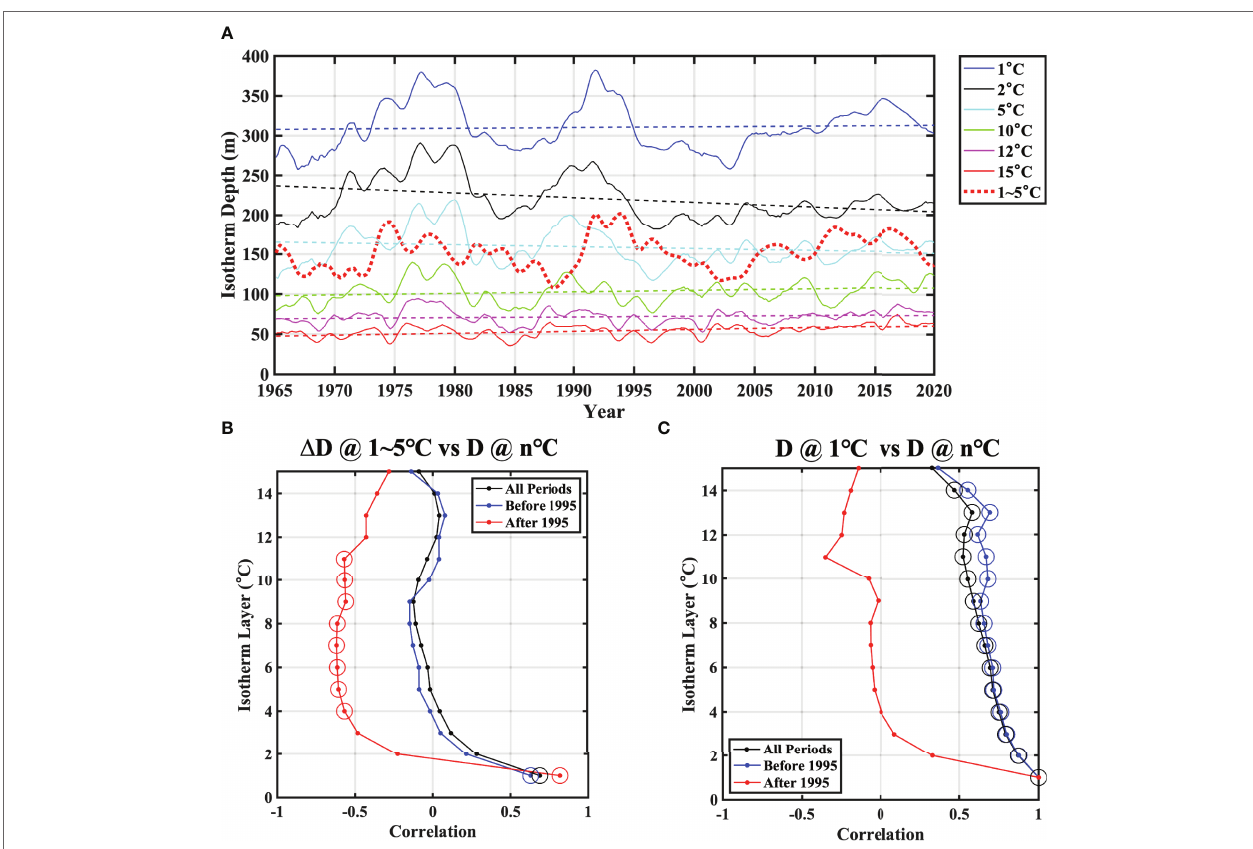
FIGURE 10 | (A) Temporal variability of isotherm depths of 1°C, 2°C, 5°C, 10°C, 12°C, and 15°C and the ESIW thickness computed from the mean temperature profile data shown in Figure 8B . Dotted lines are linear fits of each isotherm depth. (B) Correlation between the ESIW thickness shown in panel (A) and other isotherms (in °C). (C) Correlation between the isotherm depth of 1°C and other isotherms. In panels (B, C) , black line is by using the data for the whole time period. Blue line is from 1965 to 1994 (30 years), and red line is from 1995 to 2020 (25 years). Open circles denote where the significances are above